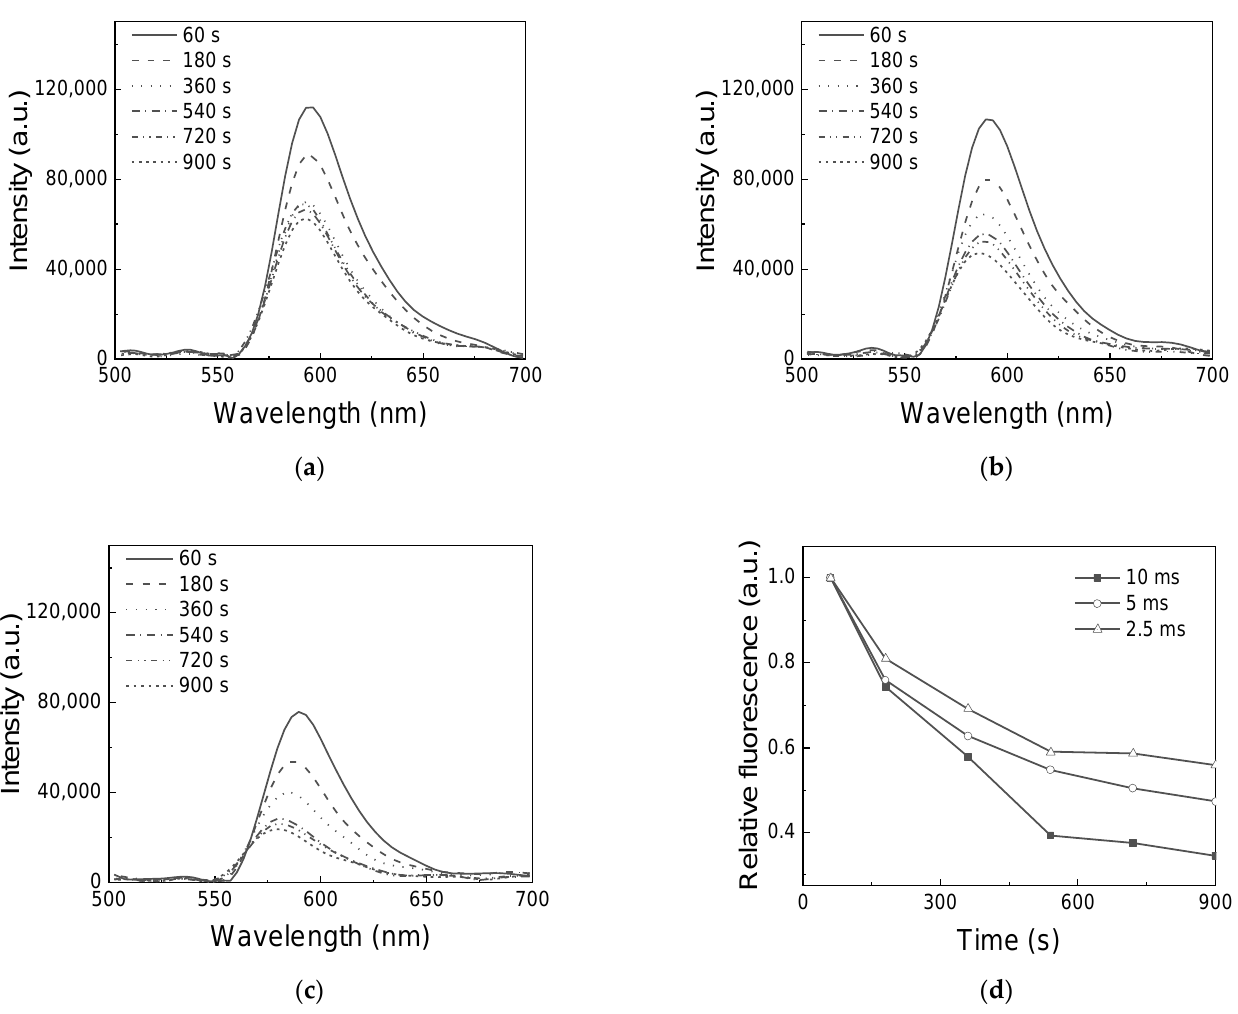
Figure 5. The change in the fluorescence spectra along with the irradiation time when the pulse width was adjusted to ( a ) 2.5 ms, ( b ) 5 ms, and ( c ) 10 ms. ( d ) The relative fluorescence changes with irradiation time.